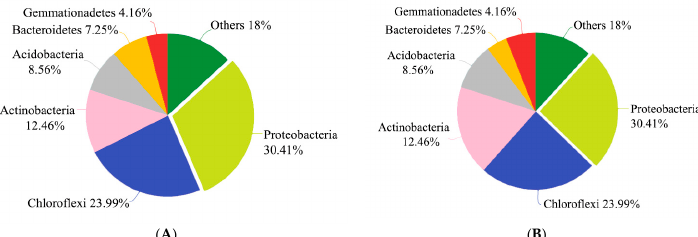
Figure 12. Computation of the sample mean of community composition of the eco-ditch ( A ) and the soil ditch ( B ).